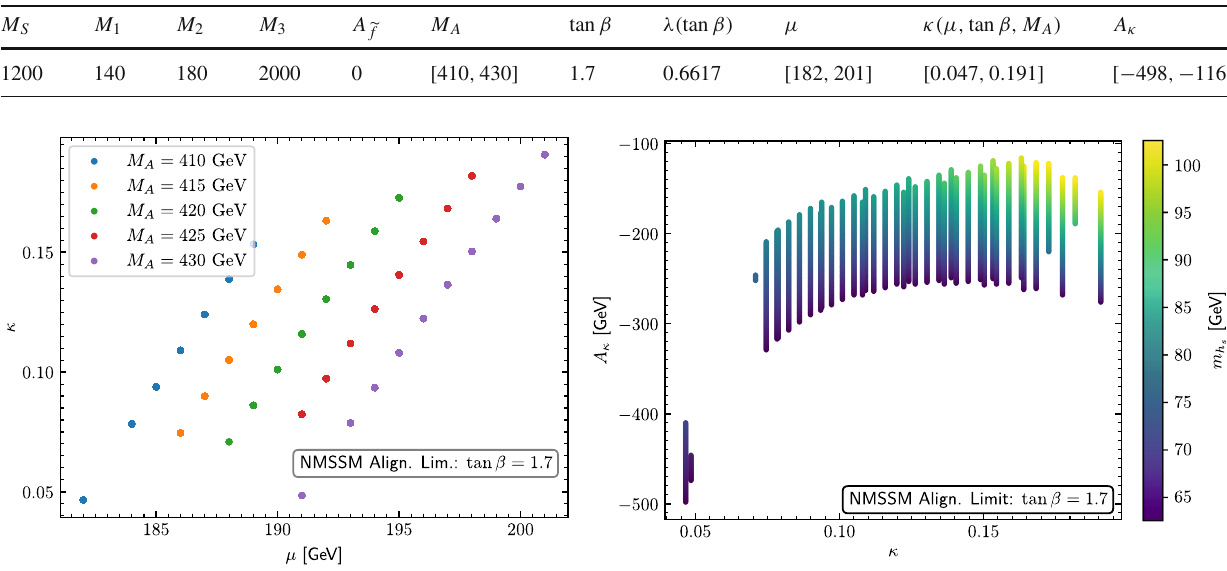
Table 3 Parameter values for the scan in the alignment limit of the NMSSM with tan β = 1 . 7 for investigating a possible realization of the t ¯ t